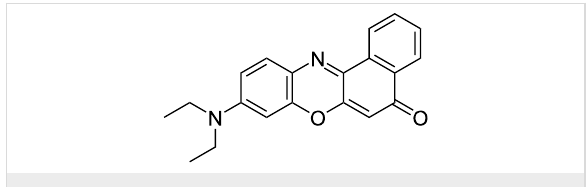
Figure 1: Molecular structure of Nile red